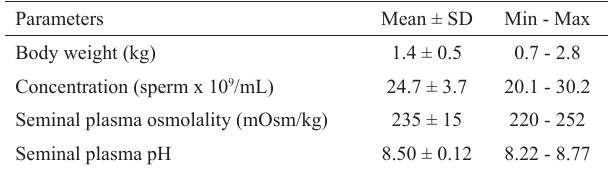
Table 1. Body weight and some fresh sperm features of Prochilodus lineatus (n=15 males; mean ± SD; min – max = minimum and maximum values) after carp pituitary